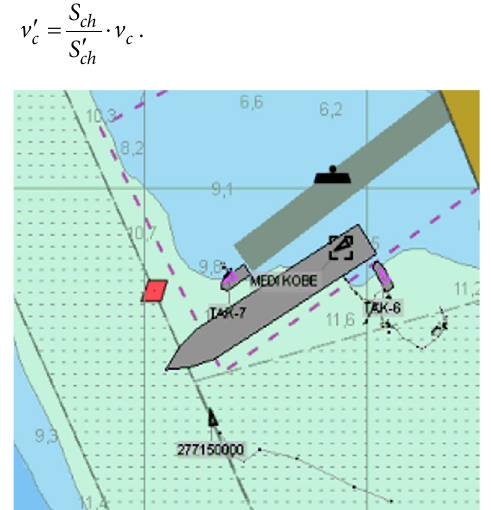
Fig. 8. A mooring ship partly blocks current flow and decreases the cross square of the